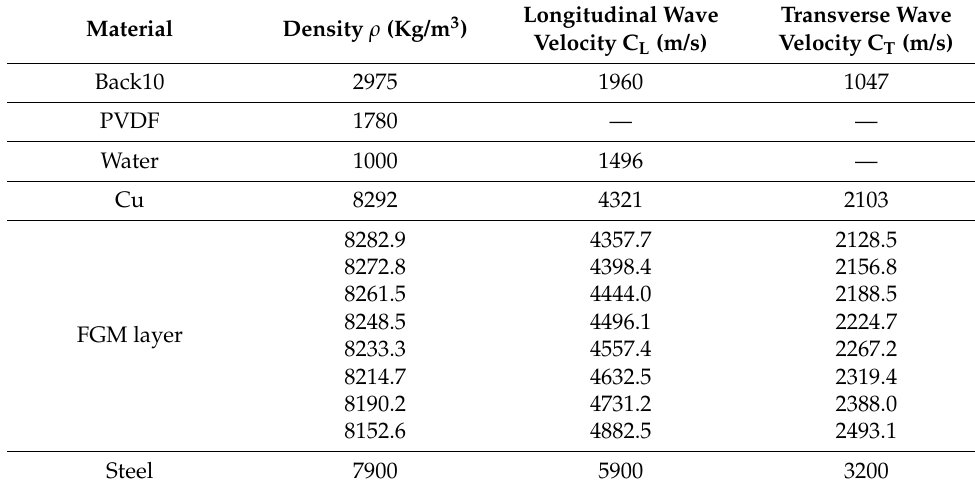
Table 3. The material property parameters of the